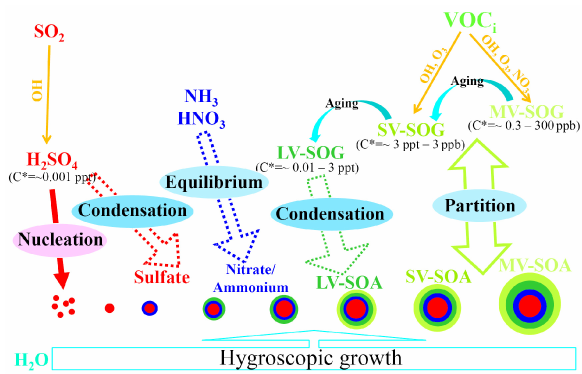
Figure 1. Fig. 1. Schematic illustration of particle formation and growth as well as oxidation aging processes in the atmosphere. See text for